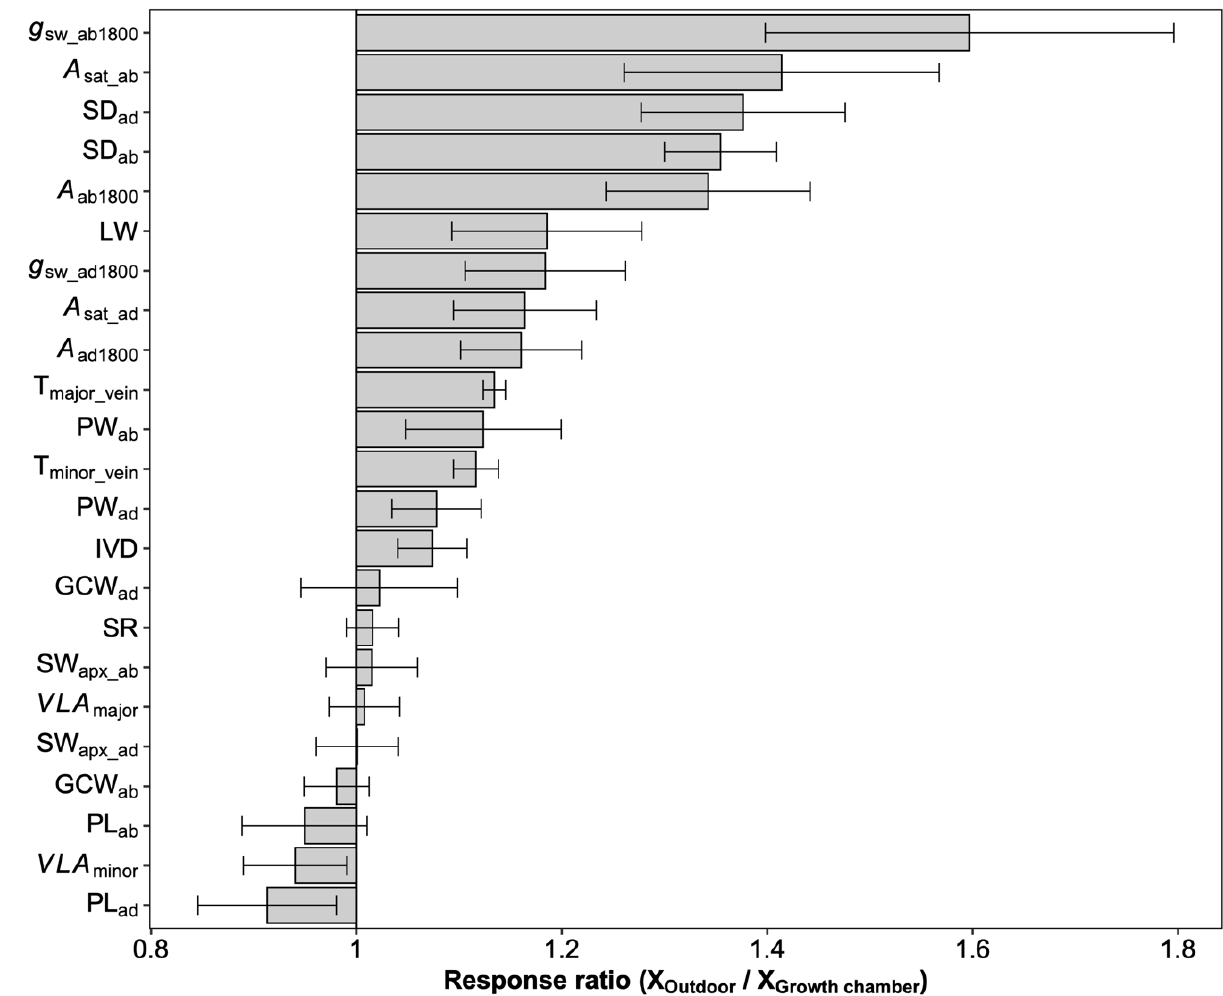
Figure 4. The overall response ratio of leaf traits to growth environments. Bars denote the response ratios, and the error bars are the 95% confidence intervals (calculations see M&M section). A response ratio smaller than, equal to, and larger than 1 corresponds to a lower, equal, and higher value under outdoor conditions than under growth chamber conditions, respectively. The response ratios statistically differed from 1 if their confidence intervals did not cover 1. See Table 1 for definitions of the variables.